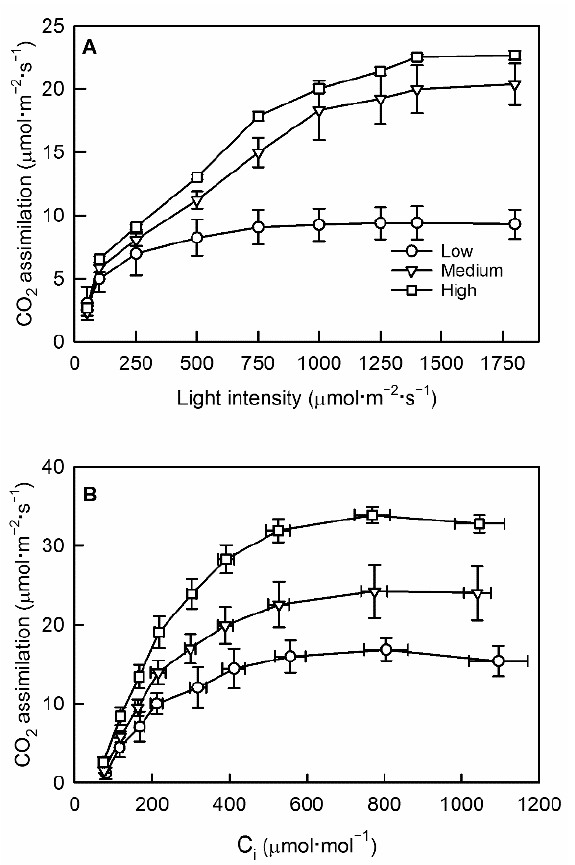
Figure 2. Effects of crop load on light response curve ( A ) and A/Ci response curve ( B ) of apple leaves. For A, each data point represents mean ± SE ( n = 3). For B, each data point represents mean ± SE for leaf Ci (horizontal, n = 3) and CO 2 assimilation (vertical, n = 3). Parameters of A/Ci curves for different crop load levels were estimated according to [4] and as follows: for low crop load, Vc,max = 50 µmol·m − 2 s − 1 , J = 82 µmol·m − 2 ·s − 1 , TPU = 5.7 µmol·m − 2 ·s − 1 , Rd = 1.14 µmol·m − 2 ·s − 1 ; for medium crop load, Vc,max = 66 µmol·m − 2 s − 1 , J = 114 µmol·m − 2 ·s − 1 , TPU = 8.4 µmol·m − 2 ·s − 1 , Rd = 1.15 µ mol · m − 2 · s − 1 ; for high crop load, Vc,max = 90 µ mol · m − 2 s − 1 , J = 160 µ mol · m − 2 · s − 1 , TPU = 11.5 µ mol · m − 2 · s − 1 , Rd = 1.25 µ mol · m − 2 · s − 1